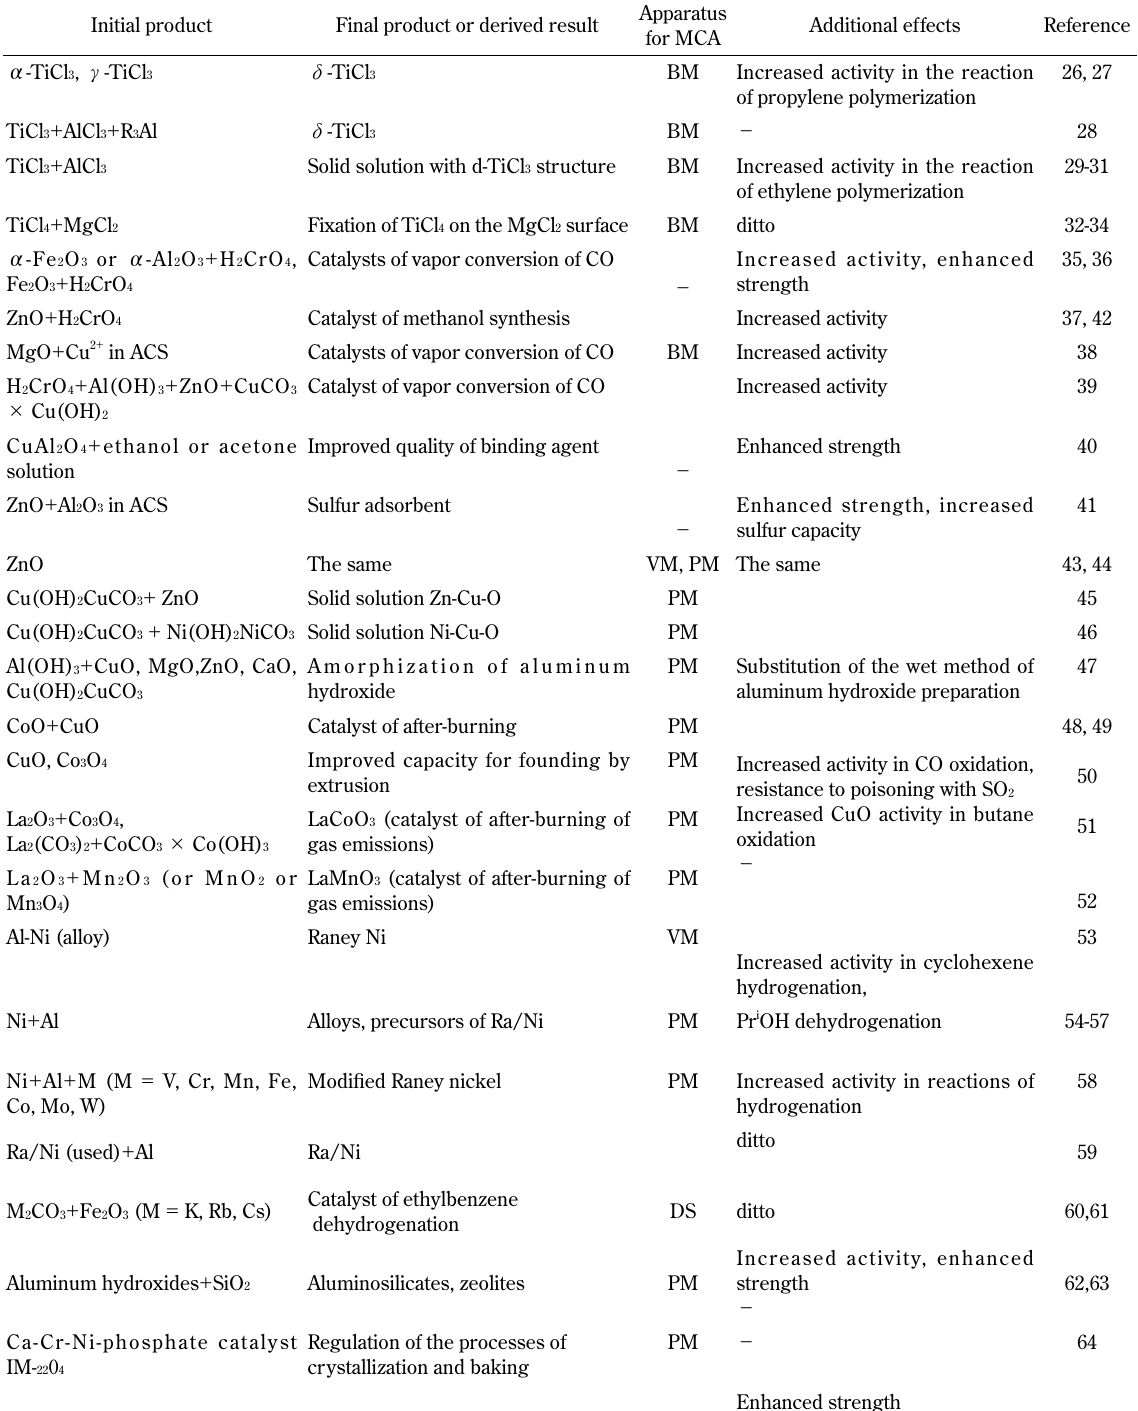
Table 2 Results of the MCA application for the preparation of catalysts Initial